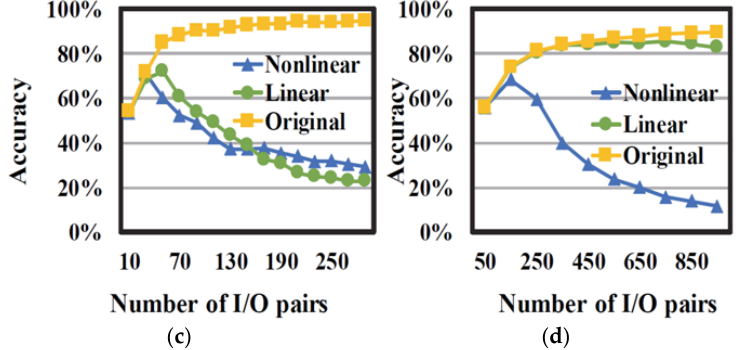
Figure 58. Accuracy between naïve and revised designs for ( a ) Digit, ( b ) Faults, ( c ) Image, and ( d ) MNIST benchmarks.